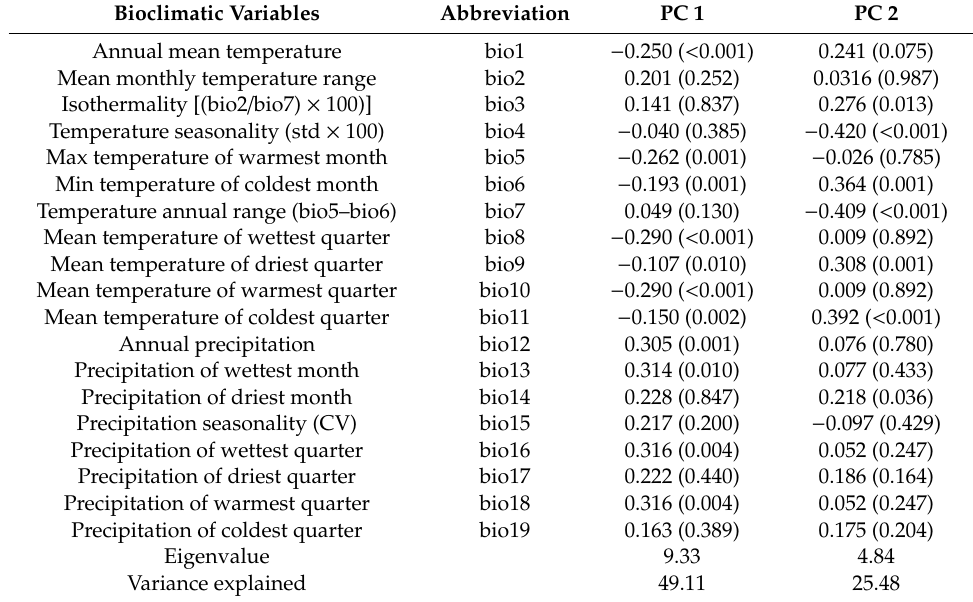
Figure 6. Correlations of the ring–width index (RWI) provenance chronologies with monthly climatic parameters, from March in the previous year through October in the current year: temperature (panel A ), precipitation (panel B ), SPEI3 (panel C ), and SPEI6 (panel D ) over the period 1970–2014. Colors represent correlation coe ffi cients; non–significant correlations are not represented (white). * and ** demarcate a significance level of correlation ( p < 0.05 and p < 0.01, respectively). Table 3. Pearson’s correlation coe ffi cients ( p –value) between climatic variables and the first two major components, with eigenvalues and the explained